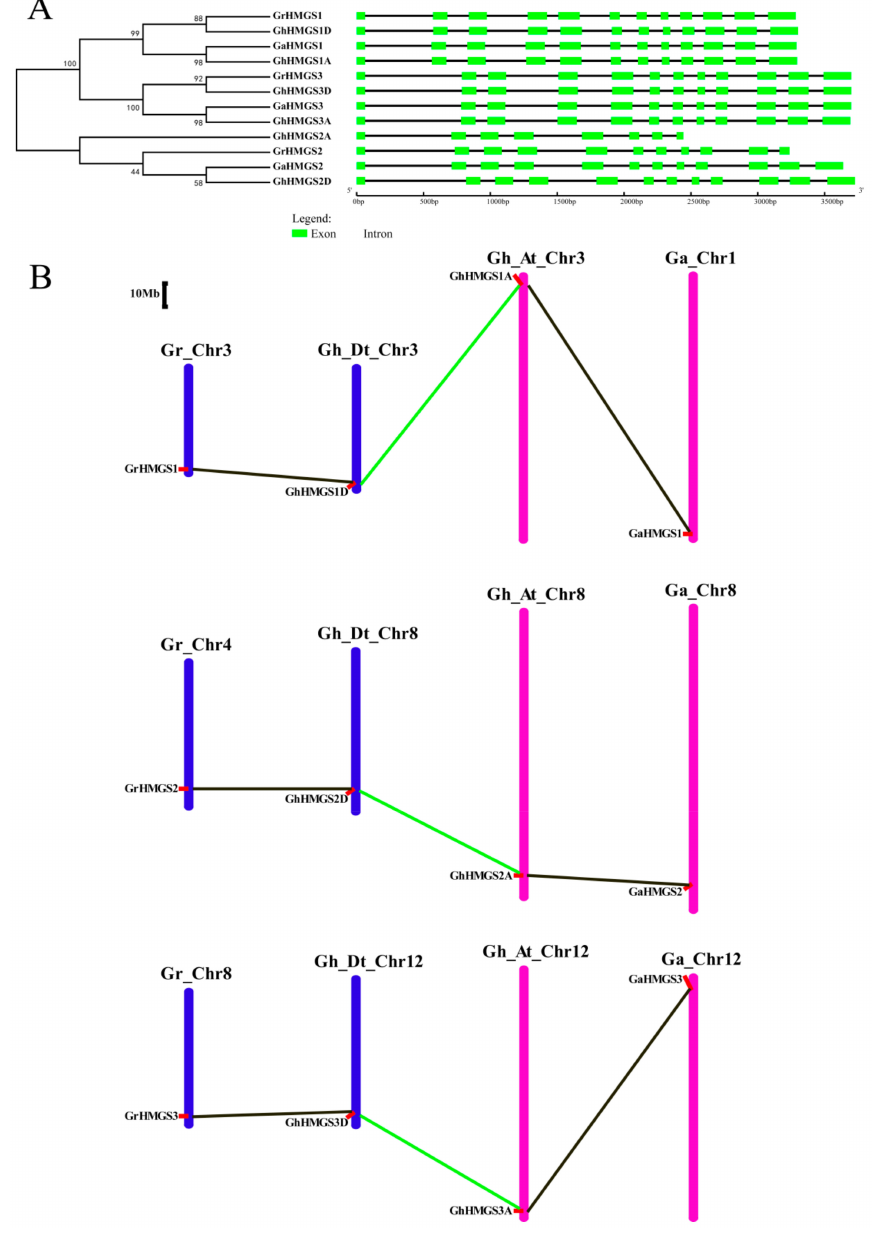
Figure 3. Phylogenetic relationships, gene structures, and chromosomal distributions of Gossypium HMGS genes. ( A ) Phylogenetic relationships and gene structures of HMGS genes from G. raimondii , G. arboreum , and G. hirsutum . Exons and introns are represented by green boxes and black lines, respectively. ( B ) Chromosomal distributions of HMGS genes from G. raimondii , G. arboreum , and G. hirsutum . Chromosome numbers are displayed at the top of each bar. The chromosomes of G. raimondii and the G. hirsutum D-subgenome are indicated in blue, while the chromosomes of G. arboreum and the G. hirsutum A-subgenome are indicated in magenta. The putative orthologous HMGS genes between the two diploid species and the allotetraploid species are connected by black lines, and the putative paralogous HMGS genes between the D-subgenome and A-subgenome of G. hirsutum are connected by green